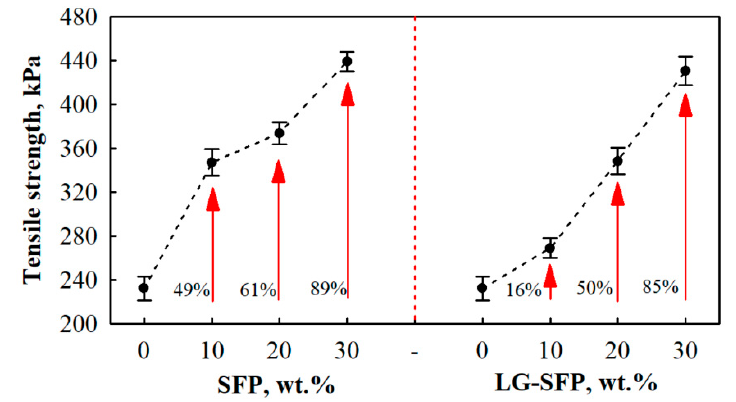
Figure 8. Tensile strength of SFP and LG-SFP modified PUR foams.